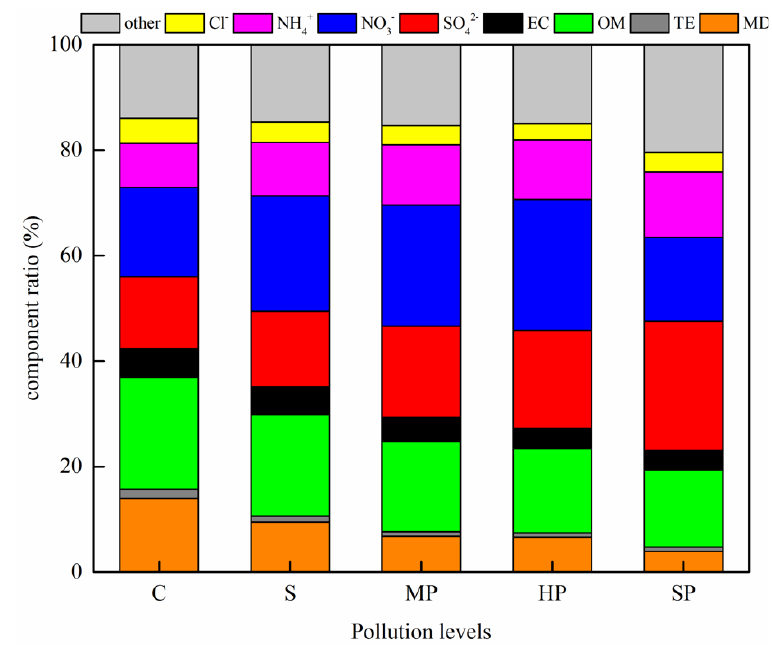
Figure 5. Compositional reconstruction of PM 2.5 pollution of different levels during the sampling period.